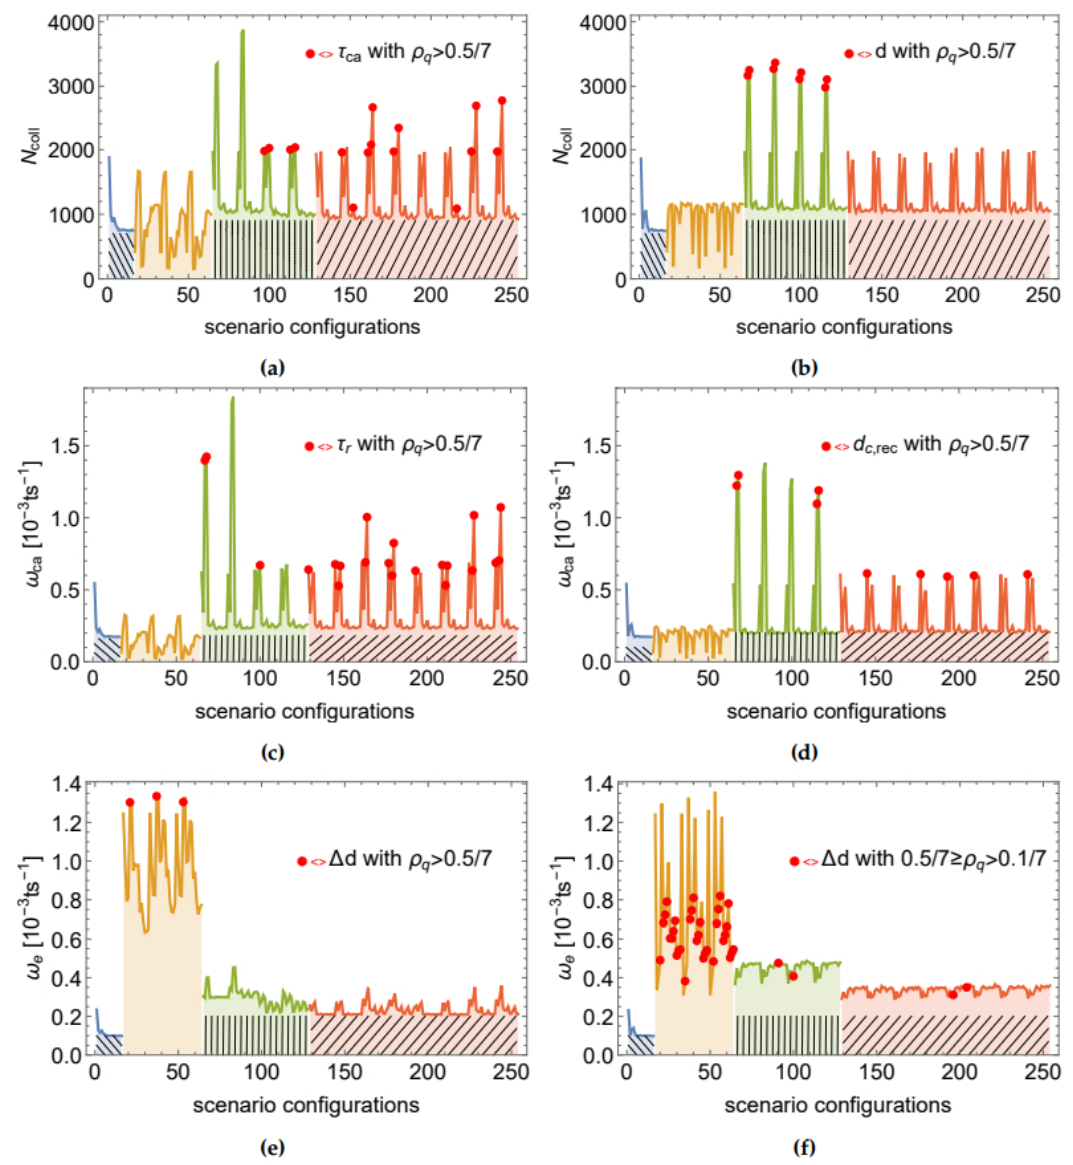
Figure 3. Swarm performance in terms of ( a , b ) N coll ; ( c , d ) ω ca and ( e , f ) ω e , respectively. For each performance measure, 256 scenario configurations were implemented (i.e., with all cue values from Equation (14)), using one of two communication modes: DCM (left) and CCM (right). The x-axis represents the IDs of the scenario configurations. The colors and the mesh patterns highlight regions that display different dynamics. Apart from ( f ), in all plots the red dots mark the scenarios in which the feature mentioned in the inset demonstrated a high value of ρ q , i.e., there was a strong support for the distribution to be power law. In ( f ), the red dots mark the scenarios with moderate support. See Supplementary Material Section3 for combined plots of N coll and d distribution in CCM over the complete set of 256 scenario